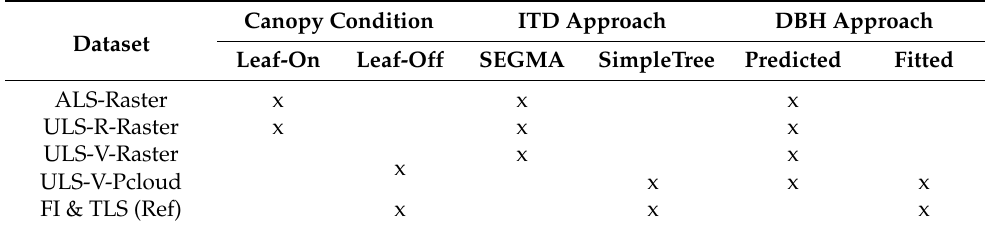
Table 3. Summary of methods that were used for individual tree detection and delineation (ITD), and for tree DBH estimation from each dataset for a given foliage condition.